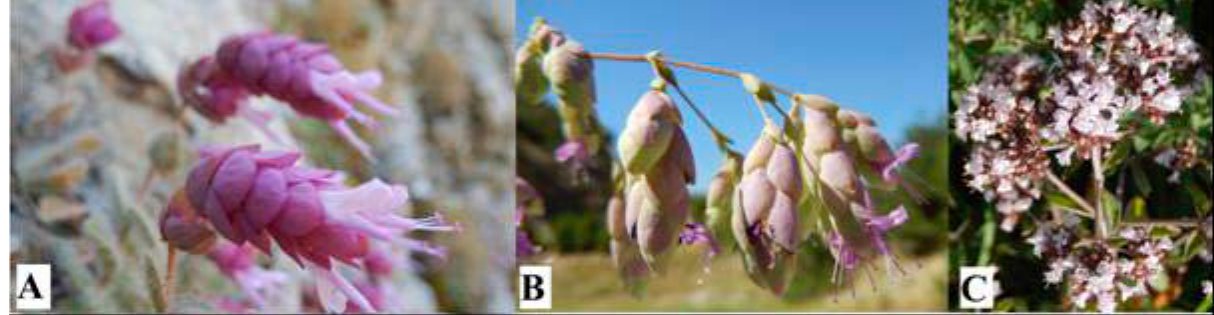
Figure 5. Inflorescence of O. ayliniae (A), O. sipyleum (B), O. vulgare subsp. vulgare (C) (photo by Tuncay